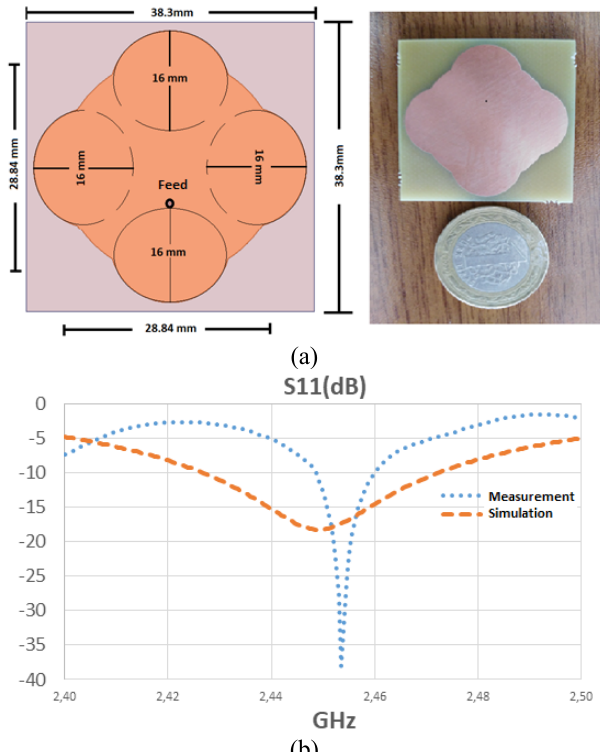
Figure 1: Antenna structure a) Dimensions and top view, b) Return loss graph.